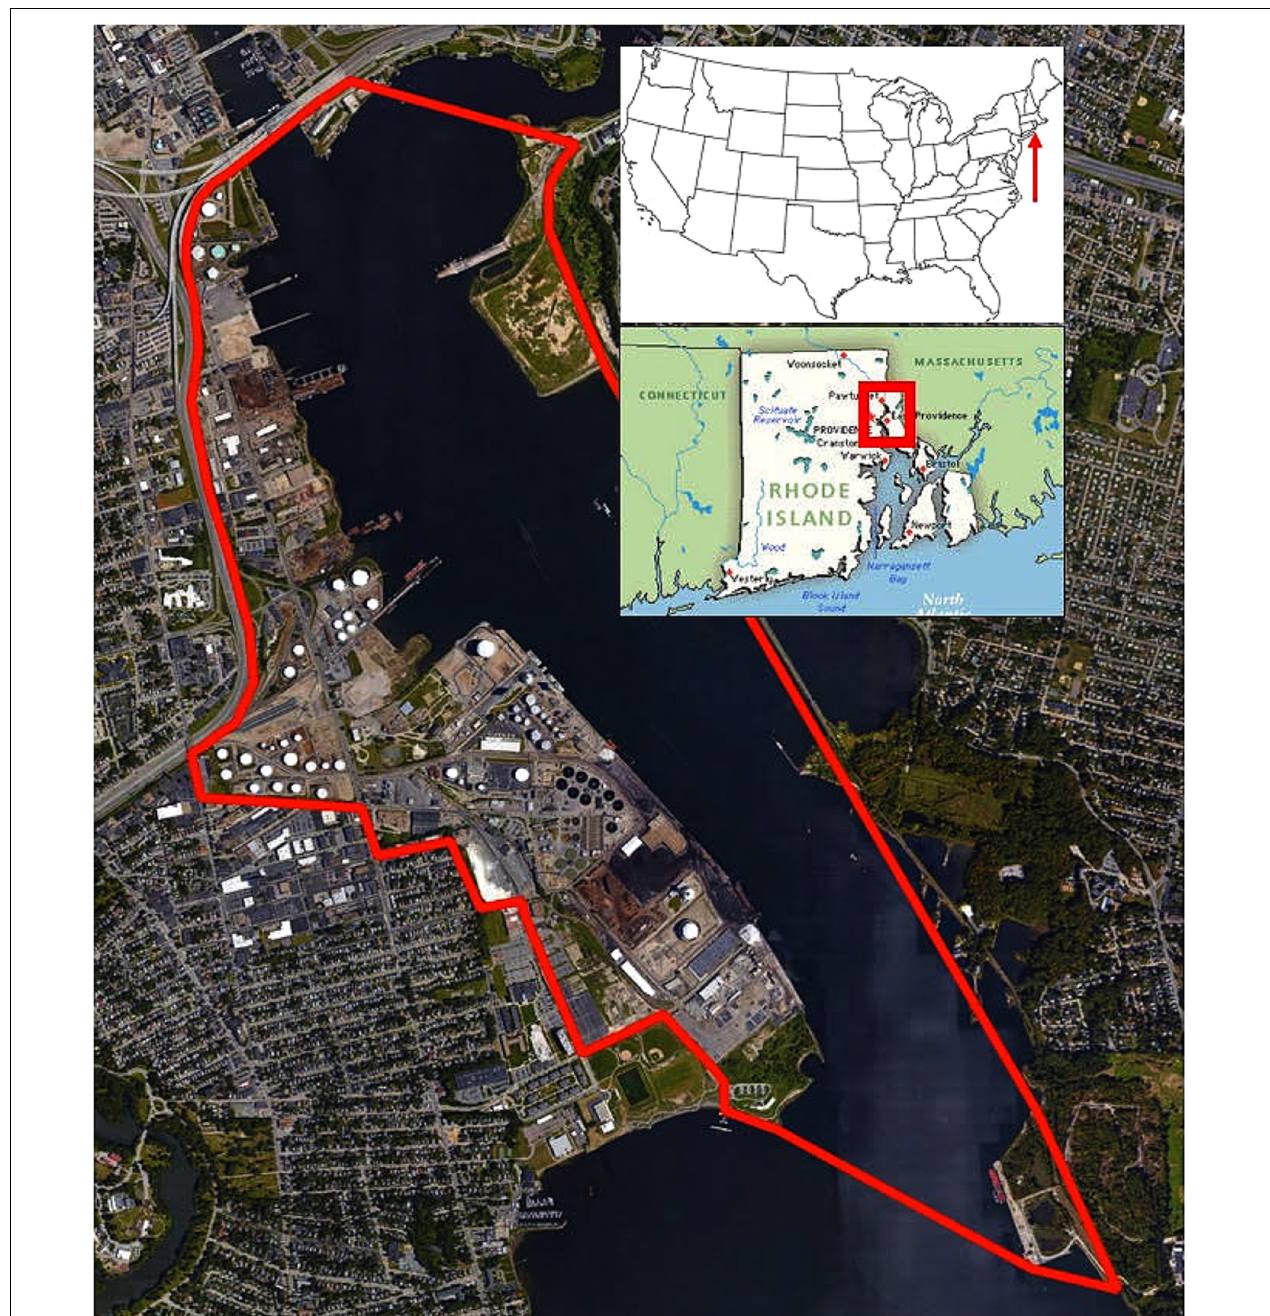
FIGURE 1 | Map of Port of Providence, RI (Becker,